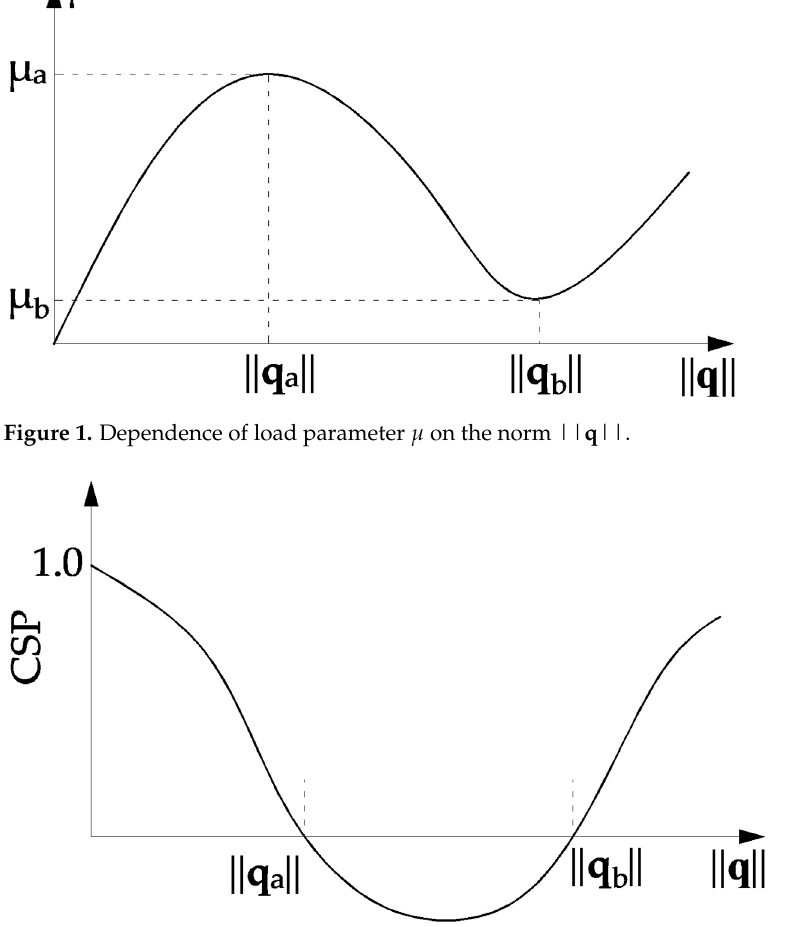
Figure 2. Dependence of CSP parameter on the norm || q ||.